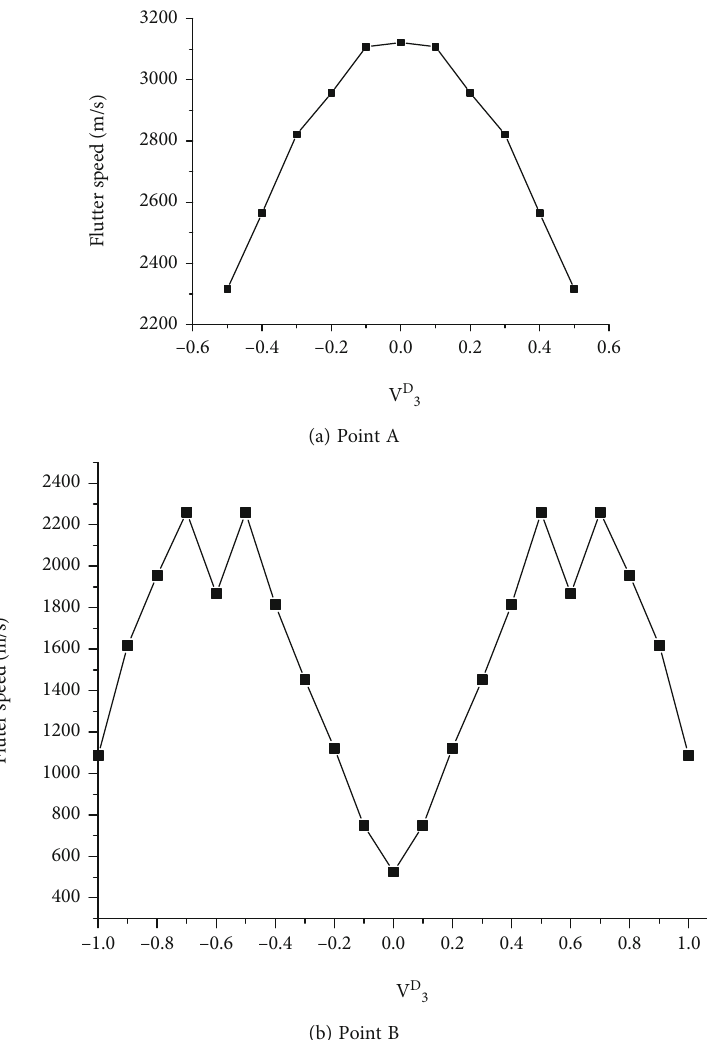
Figure 9: Flutter speed curves with V D